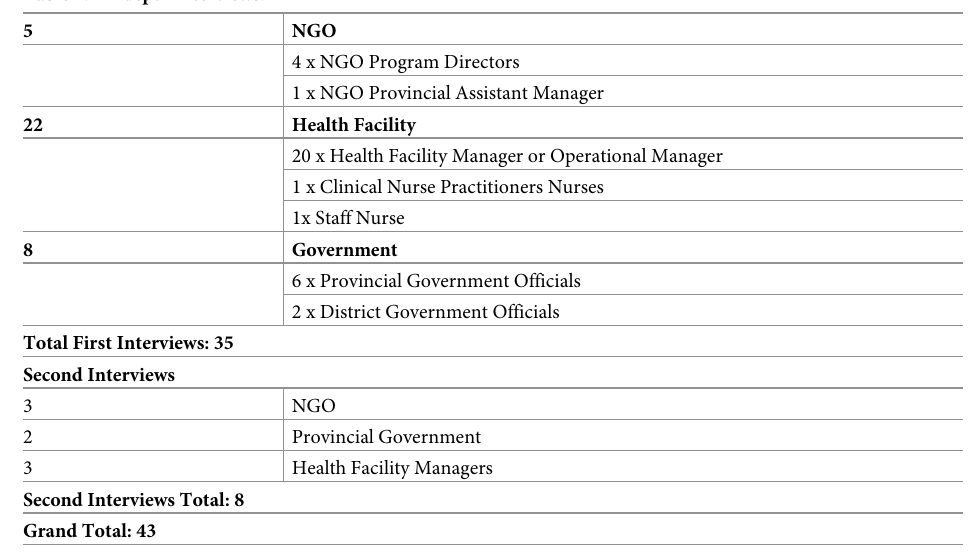
Table 2. In-depth interviews.